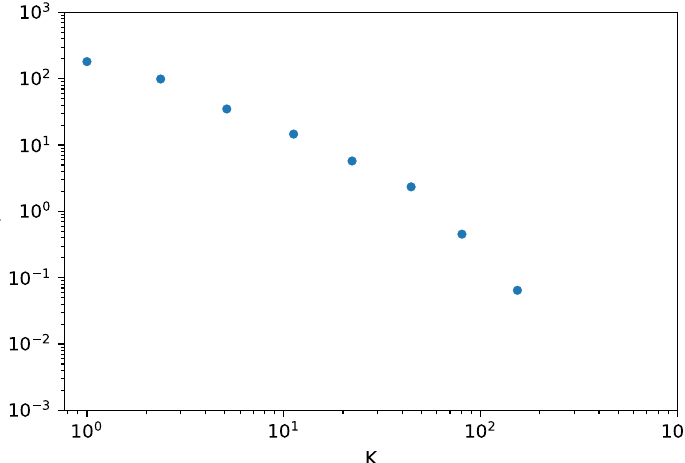
Figure 2. Degree distribution of phenotypic network. Log-binned degree distribution of the phenotypic network using a log–log scale. A power-law distribution which is a feature of scale-free networks. K represents the average degree of the bin where bin has size 2 n-1 . pK is obtained from the number of nodes found in the bin divided by the width of the